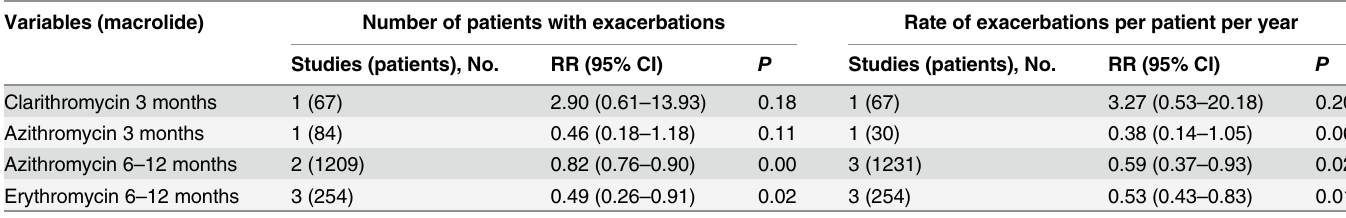
Table 2. Subgroup analyses of prophylactic macrolide treatment on the prevention of acute exacerbations of COPD. Variables (macrolide)